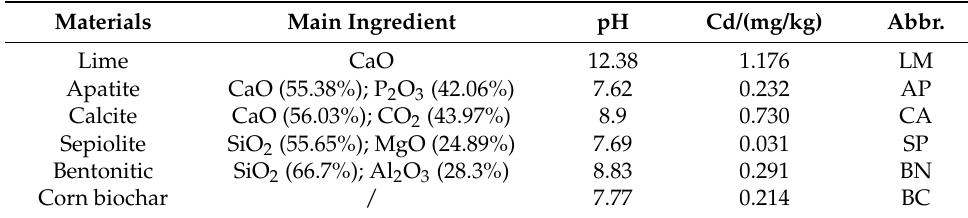
Table 2. Chemical characterization of